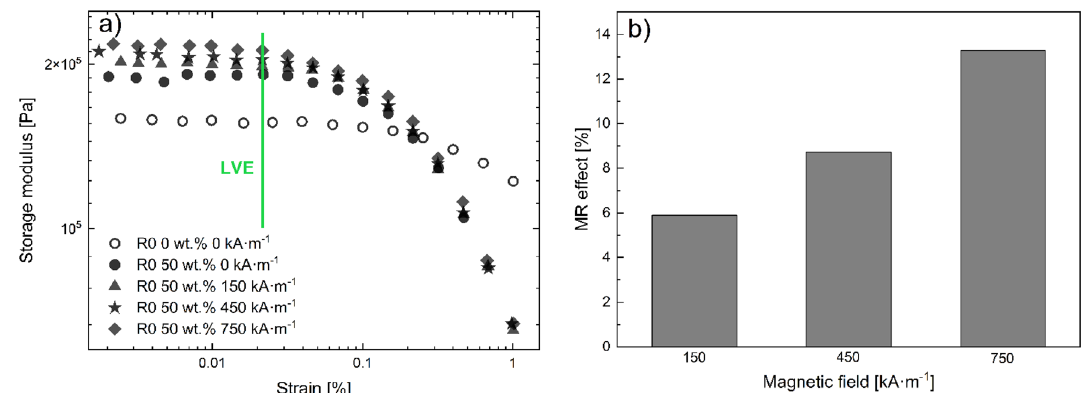
Figure 8. ( a ) Dynamic strain sweeps for samples containing 50 wt% CI particles at different magnetic fields (filled symbols; circles 0 kA m –1 ; triangles 150 kA m –1 ; stars 450 kA m –1 ; diamonds 750 kA m –1 ); neat TPU matrix (unfilled) and ( b ) MR effect for the same 50 wt%